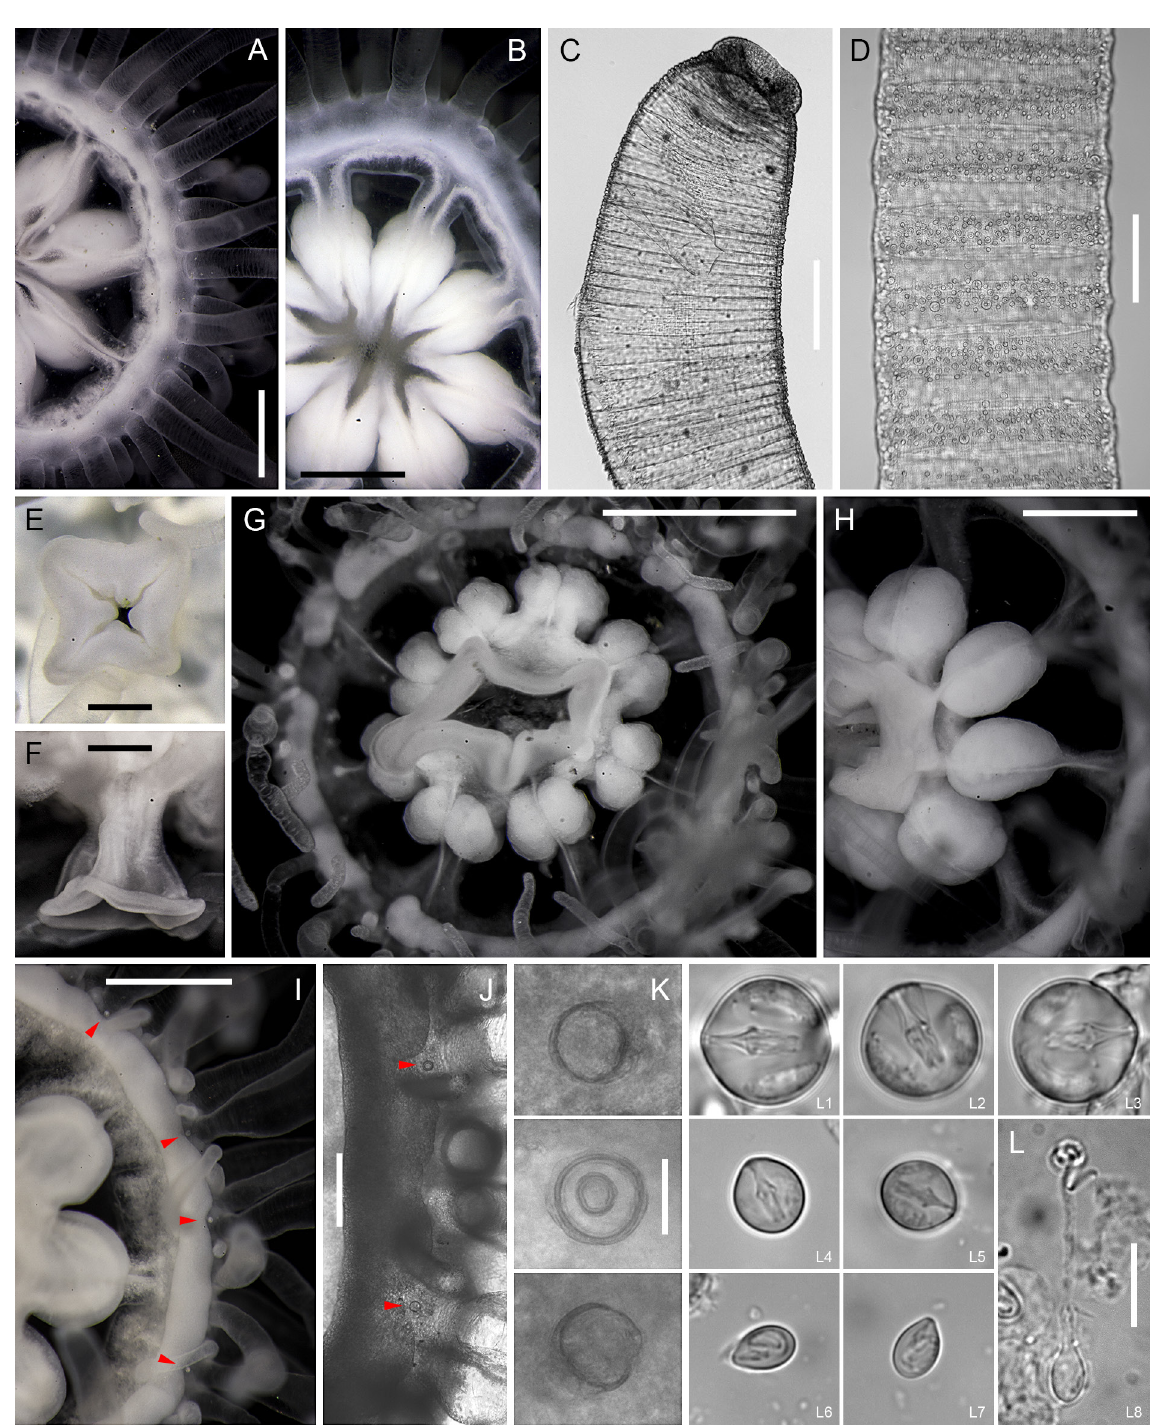
Fig. 2. Glaciambulata neumayeri Galea, Roder, Walcher, Warmuth, Kohlberg & Fischer, gen. et sp. nov. A . Arrangement pattern of the large, filiform tentacles around the bell margin. B . Aboral view of a medusa showing some radial and the ring canal. C . Distal part of an adhesive tentacle. D . Portion of a filiform tentacle, showing the arrangement of the nematocysts. E – F . The mouth in frontal (E) and lateral (F) aspects. G – H . Arrangement and structure of the gonads. I – J . Position of the statocysts (arrowheads). K . Close-ups of three statocysts. L . Cnidome. Scale bars: G = 2 mm; A, B, H, I = 1 mm; E, F = 500 µm; C, J = 200 µm; K = 30 µm; L = 10